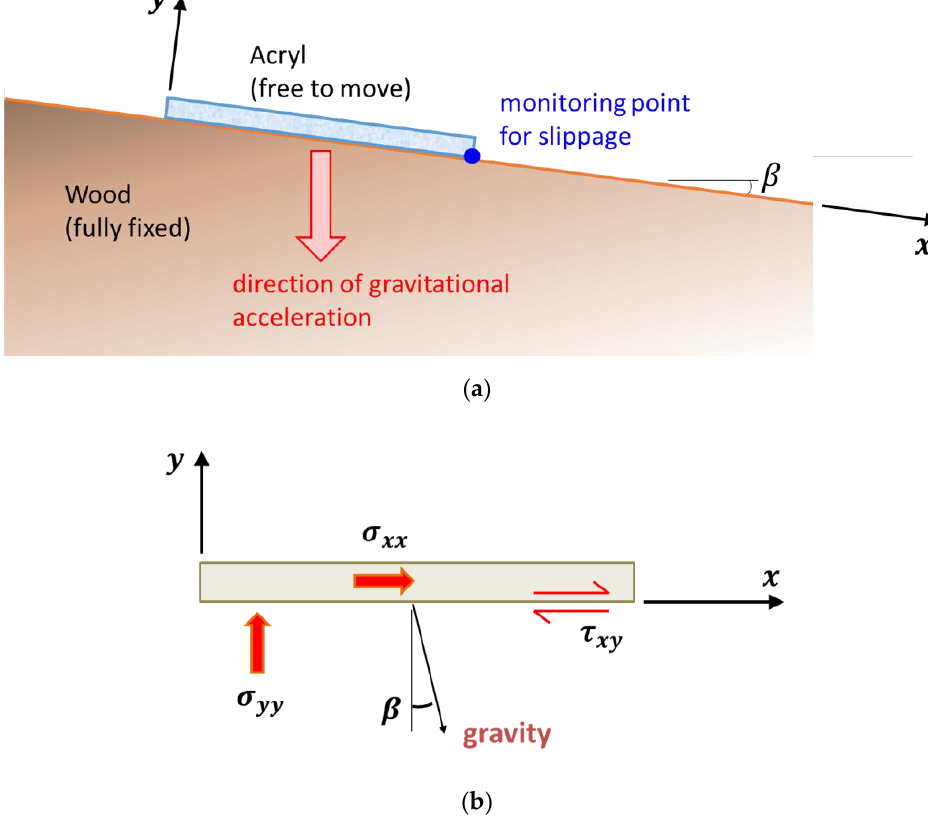
Figure 5. ( a ) Conceptual schematic of the numerical model and ( b ) definitions of the stress values around the acryl plate.